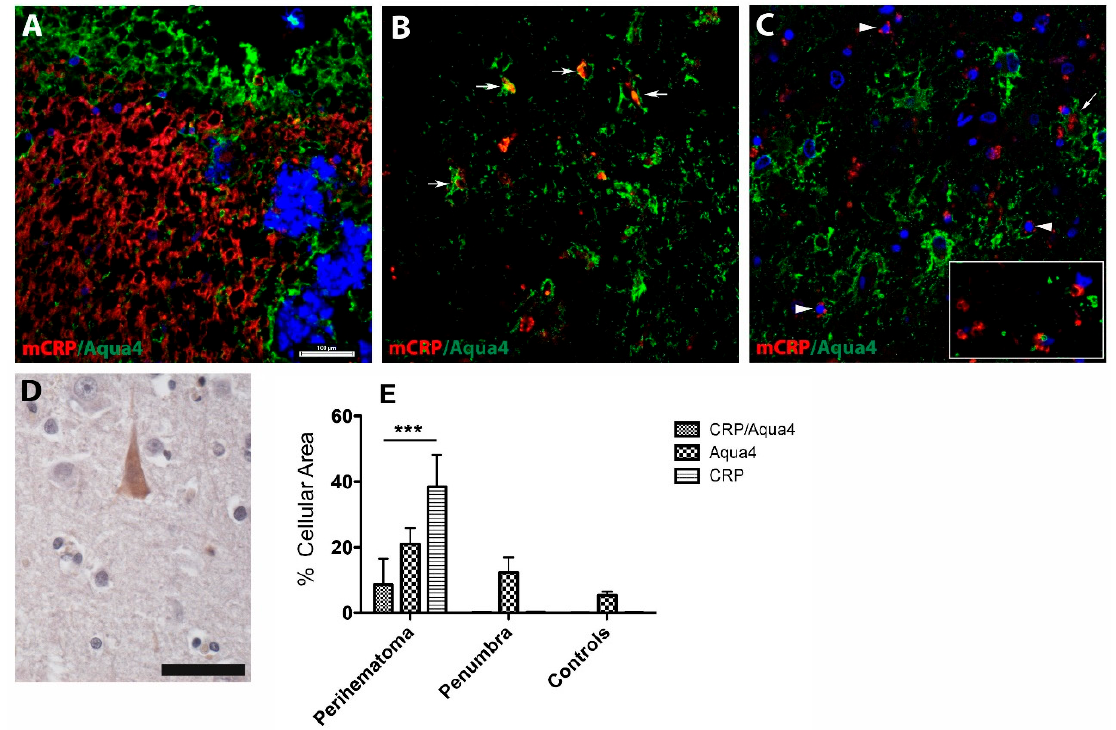
Figure 1. Monomeric C-reactive protein (mCRP) and aquaporin 4 (AQP4) expression pattern in the perihaematomal area. ( A ) In the haemorrhagic stroke area of early deaths (<48 h), mCRP was seen in numerous microvessels, while AQP4 immunoreactivity was localized adjacent to the mCRP staining and lined up with the haemorrhagic core. However, with increasing post-stroke survival time, mCRP immunostaining was detected in the lumen of microvessels expressing AQP4 ( B , arrows) and some parenchymal brain cells and some stroke-affected neurons in the surrounding areas ( C , arrowheads) and the lumen of large blood vessels ( C , arrow) and brain capillaries ( C , inset). In the normal areas of the brain, there was a weak cytoplasmic expression of mCRP in cortical neurons ( C ). A quantification of the cellular area covered by mCRP- and AQP4-positive cells revealed that mCRP-positive cell staining was predominant in the perihaematomal area, while AQP4-positive structures populated areas in the perihaematomal area followed by penumbra and, to a lesser extent, in controls. Occasionally, in the normal areas of the brain, there was a weak cytoplasmic expression of mCRP in cortical neurons ( D ). Colocalized mCRP / AQP4 cells were found only in the perihaematomal area ( E ). Scale bars are 100 µ m and 20 µ m for DAB staining. *** p = 0.001. In the figure legend, CRP indicates mCRP; Aqua4, AQP4.